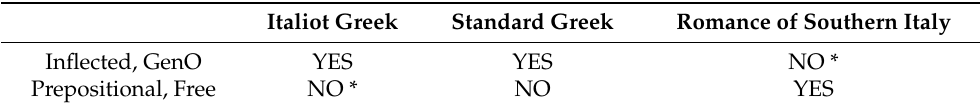
Table 5. Adnominal Table 5. Adnominal genitives. Table 5. Adnominal genitives.